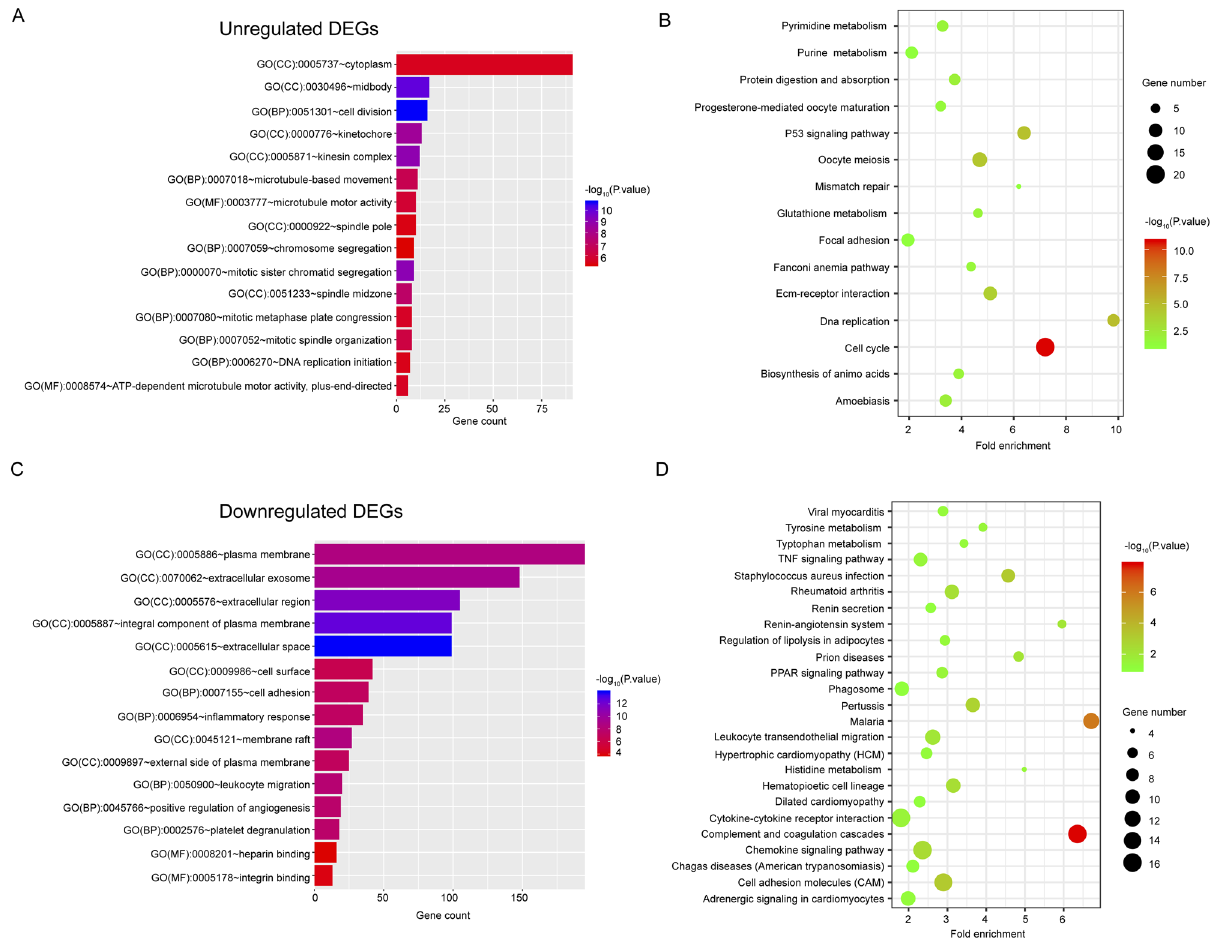
Figure 2. Functional and protein–protein interaction (PPI) networks analysis for the intersected differentially expressed mRNAs. ( A , C ) Enriched GO pathways of the significantly upregulated and downregulated genes, respectively. ( B , D ) Enriched KEGG pathways of the significantly upregulated and downregulated genes, respectively. BP biological process; CC cellular component; MF molecular function; GO Gene Ontology; KEGG Kyoto Encyclopaedia of Genes and